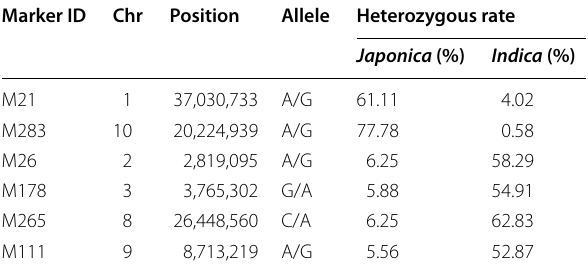
Table 2 Heterozygous rate of markers showed differences between japonica and